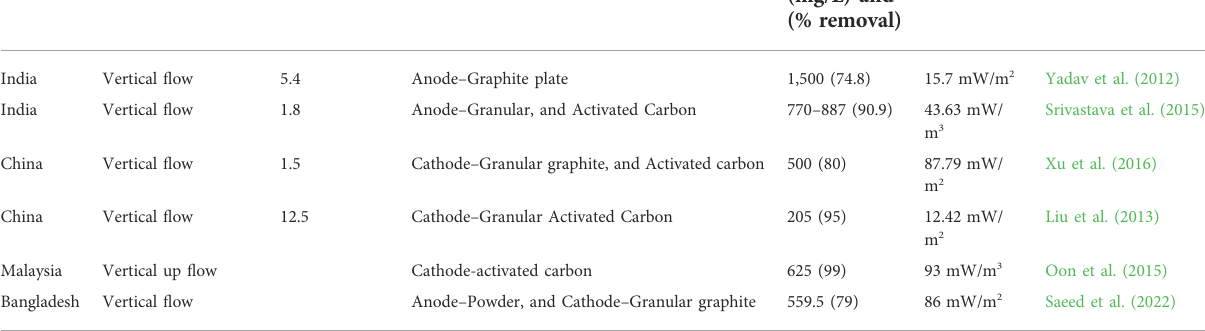
TABLE 5 Reported performance of